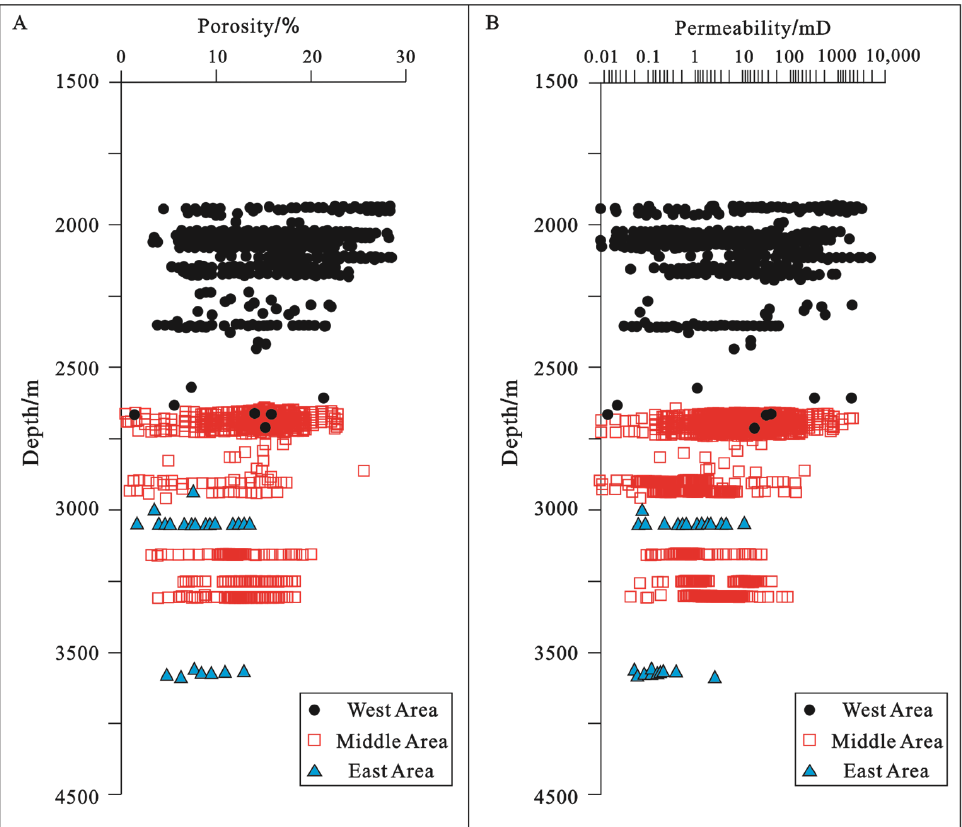
Figure 10. The relationship between ( A ) porosity and ( B ) permeability and depth in the western, central, and eastern areas. Table 3. The reservoir classification standards table.